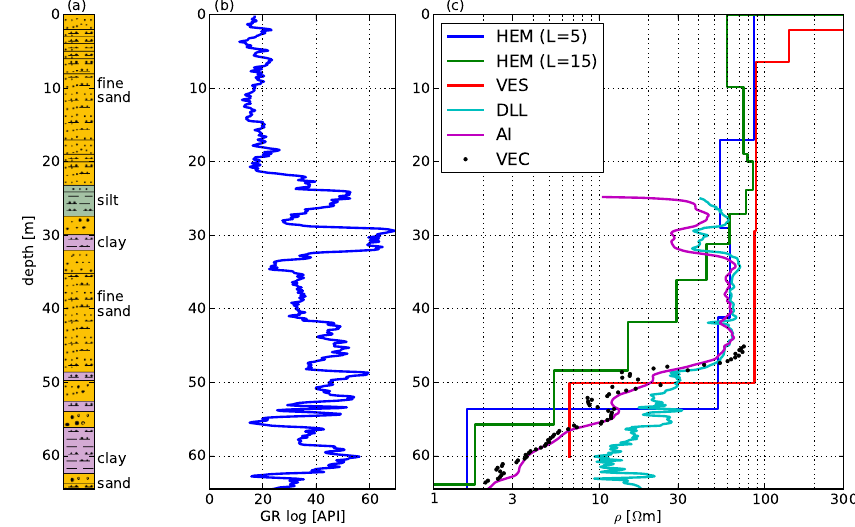
Fig. 2. Lithology (a) , gamma ray (b) and resistivity information (c) at the CLIWAT II borehole: 5-layer and 15-layer HEM solution, VES model, dual laterolog (DLL), array induction (AI) log and vertical electric chain (VEC).